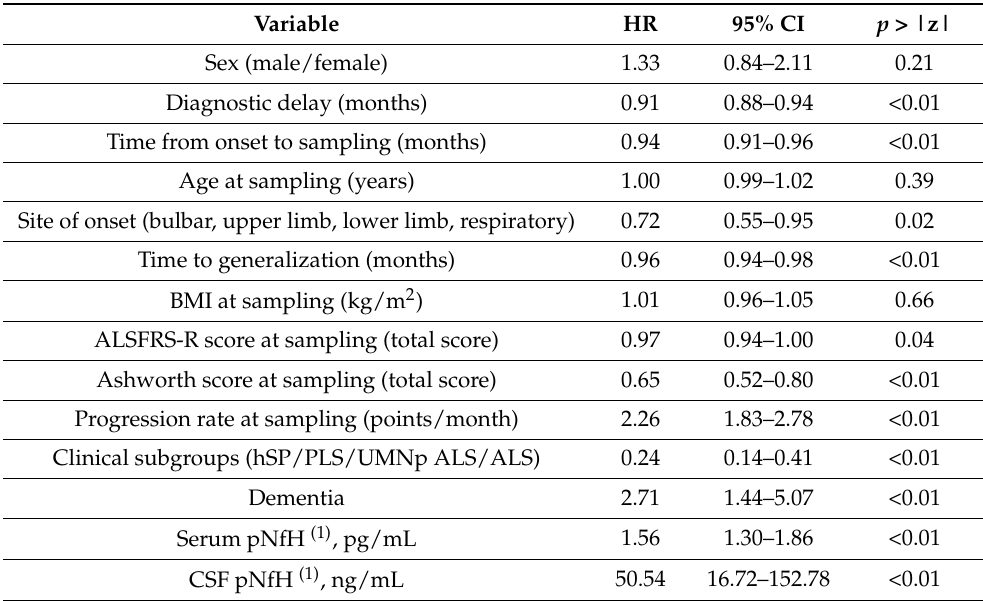
Table 5. Prognostic role of clinical and biological features in tracheostomy-free survival in all- groups